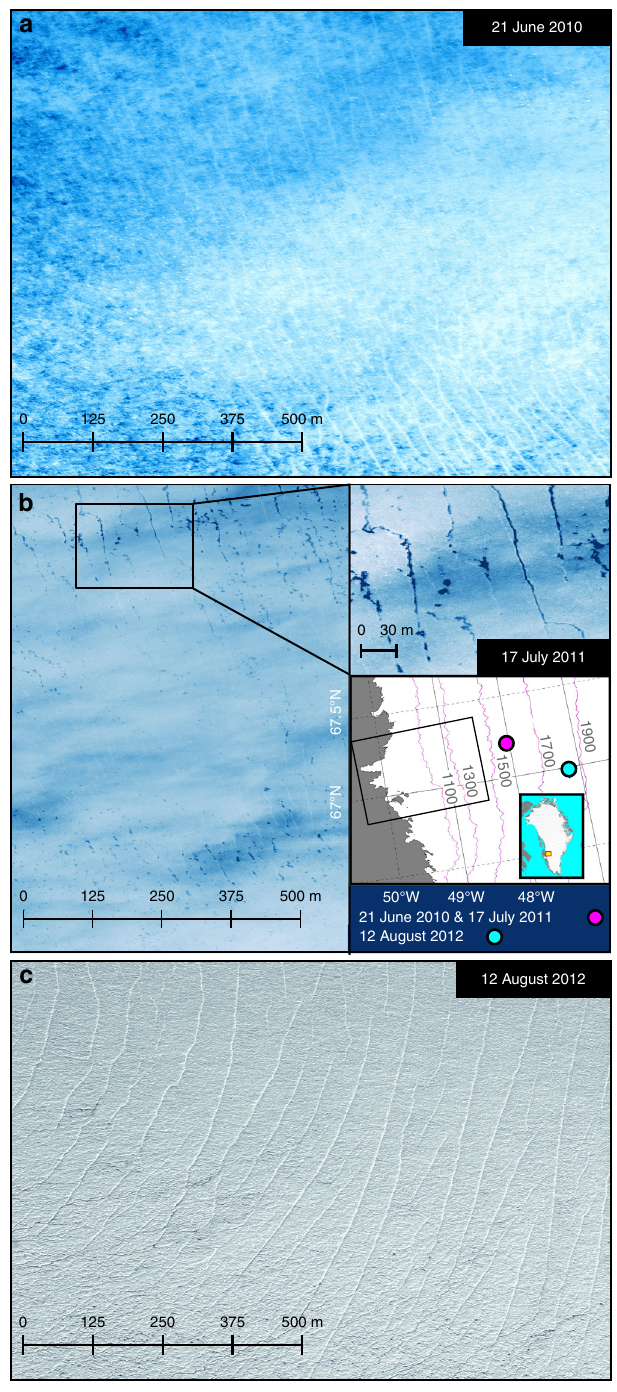
Fig. 6 High-elevation crevasses on the Greenland Ice Sheet. a Worldview image acquired on 21 June 2010 showing snow- fi lled crevasses at 1540 m elevation, 95 km inland from the ice sheet margin (48.05°W, 67.20°N) during a cascading lake drainage event (see Fig. 1b – d for contemporaneous model outputs). b Worldview image showing water- fi lled crevasses in the same area on 17 June 2011. Inset shows approximate location of imagery (coloured dots) and domain of numerical model (black box). c Worldview image from 12 August 2012 showing high-altitude crevasses at the S10 site (47.165W, 66.985N) at 1800 m elevation, 135 km inland from the margin, which is where Doyle et al. 16 observed year-on-year increases in ice fl ow consistent with forcing by supraglacial lakes (Imagery © 2018 DigitalGlobe,